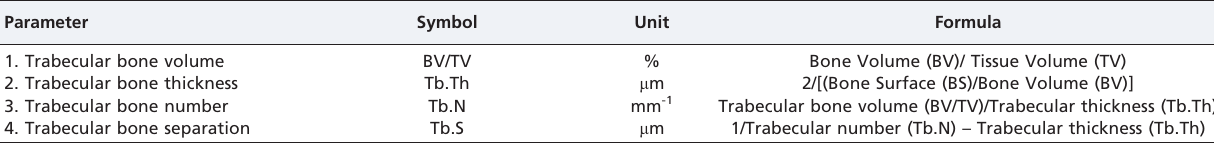
Table 1 - Formula for calculating the structural parameter values. Parameter